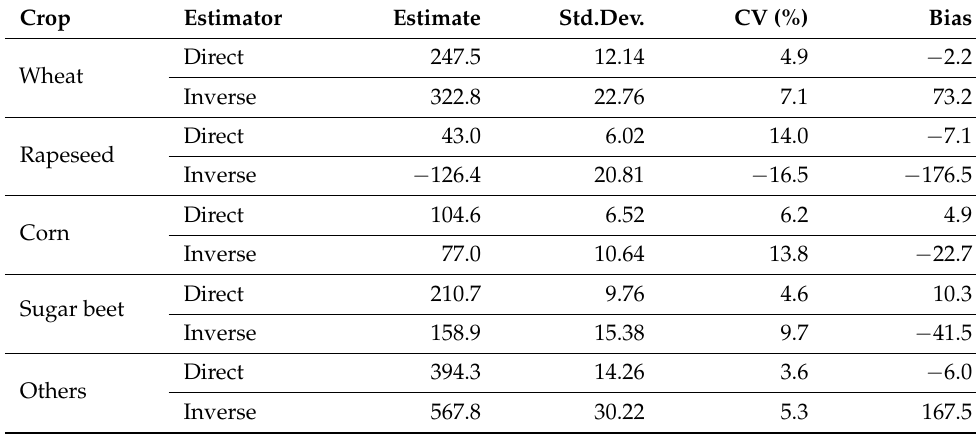
Table A2. Statistical performances per crop for the RS strategy. Crop